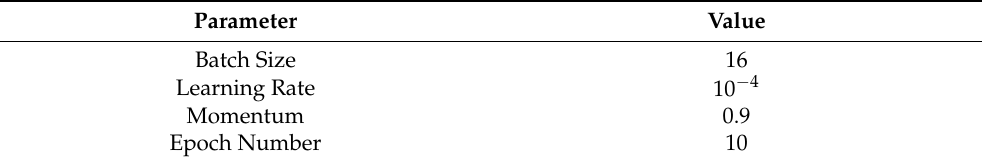
Table 5. Parameters used in the training procedure.